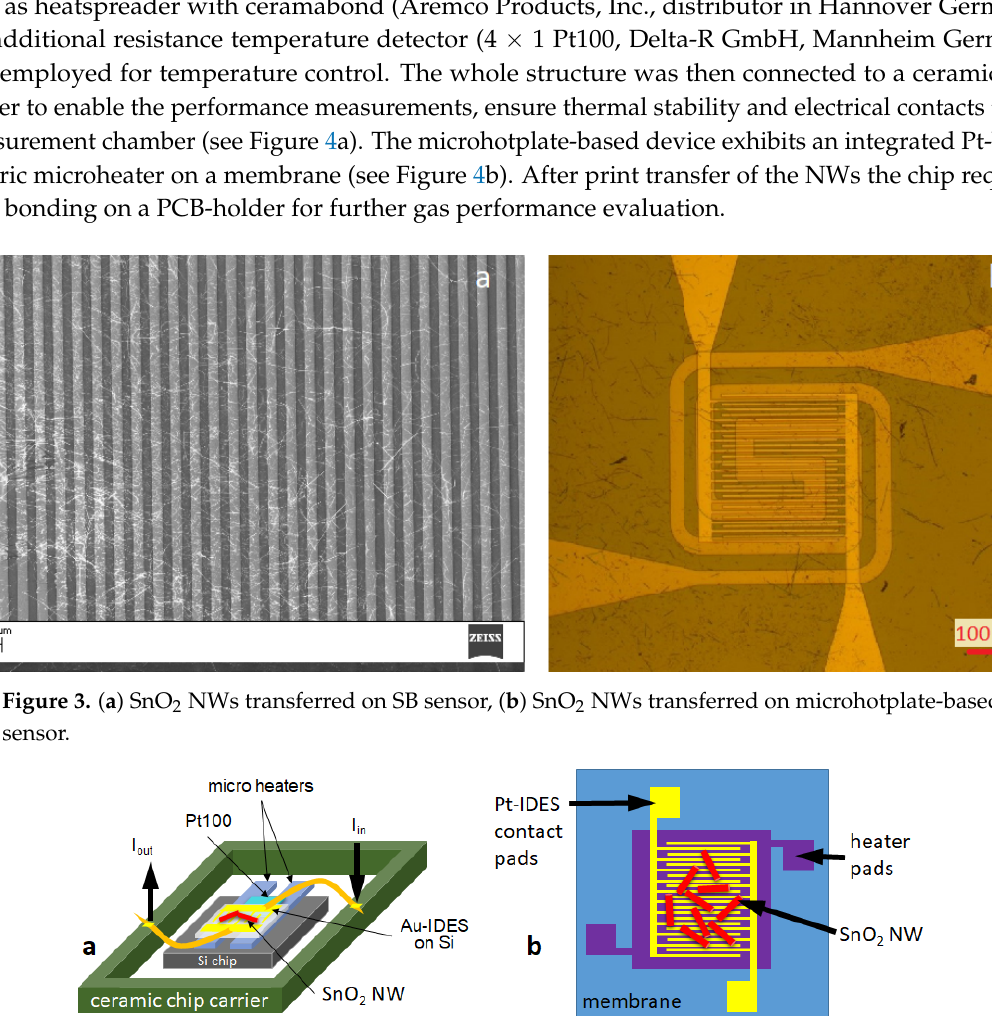
Figure 4. ( a ) Si-based gas sensing device scheme with Au-IDES and external heating, ( b ) Scheme of membrane-based microhotplate gas sensing device with Pt-IDES and an integrated